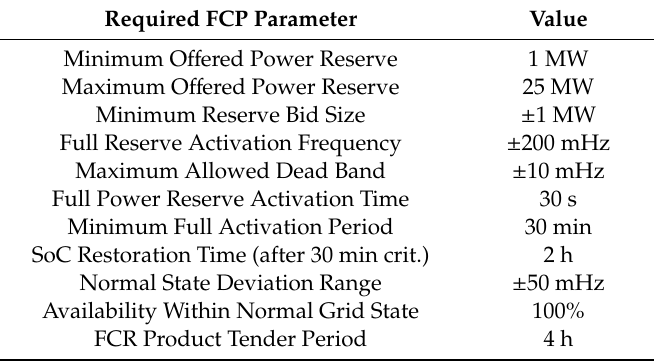
Table 1. Summary of the central requirements and conditions for the provision of the frequency containment reserve (FCR) service within the synchronously operating EU system. FCP: frequency containment process and SoC: state of charge. Required FCP